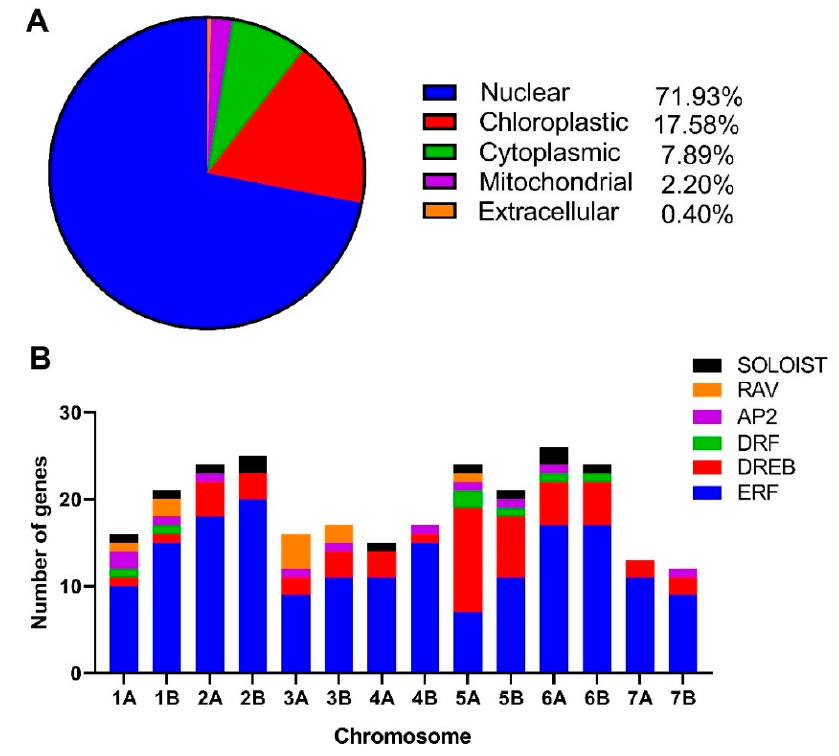
Figure 1. Subcellular localization of TtAP2 / ERF proteins in durum wheat ( A ) and distribution of the TtAP2 / ERF genes on the durum wheat chromosomes in both the A and B subgenomes ( B ).